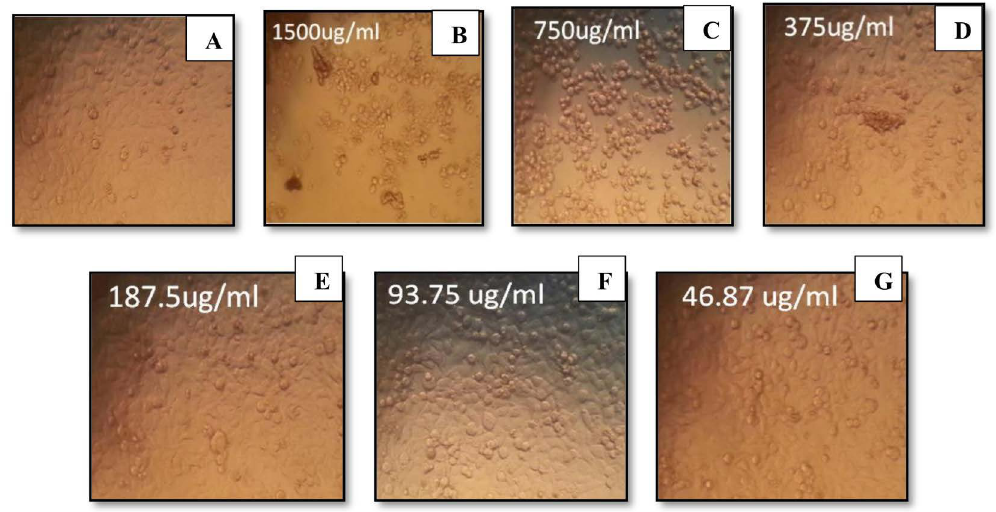
Fig. 6. Effect of different endotoxin concentrations on cell viability of Caco-2 (A) Control (untreated) Caco-2 cells. (B-G) Caco-2-treated cells with endotoxins